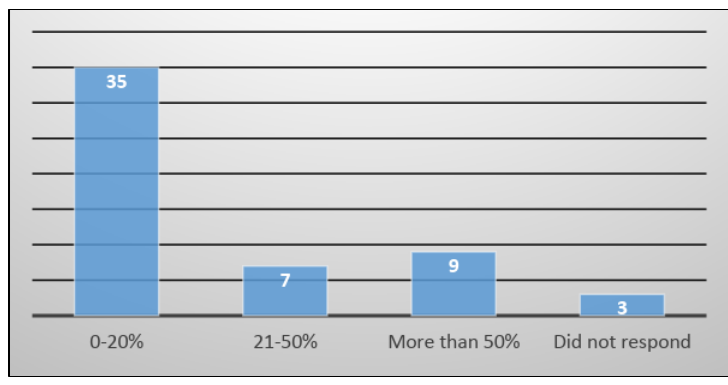
Figure 1. Percent of Working Time Spent Mentoring Microentrepreneurs Face to